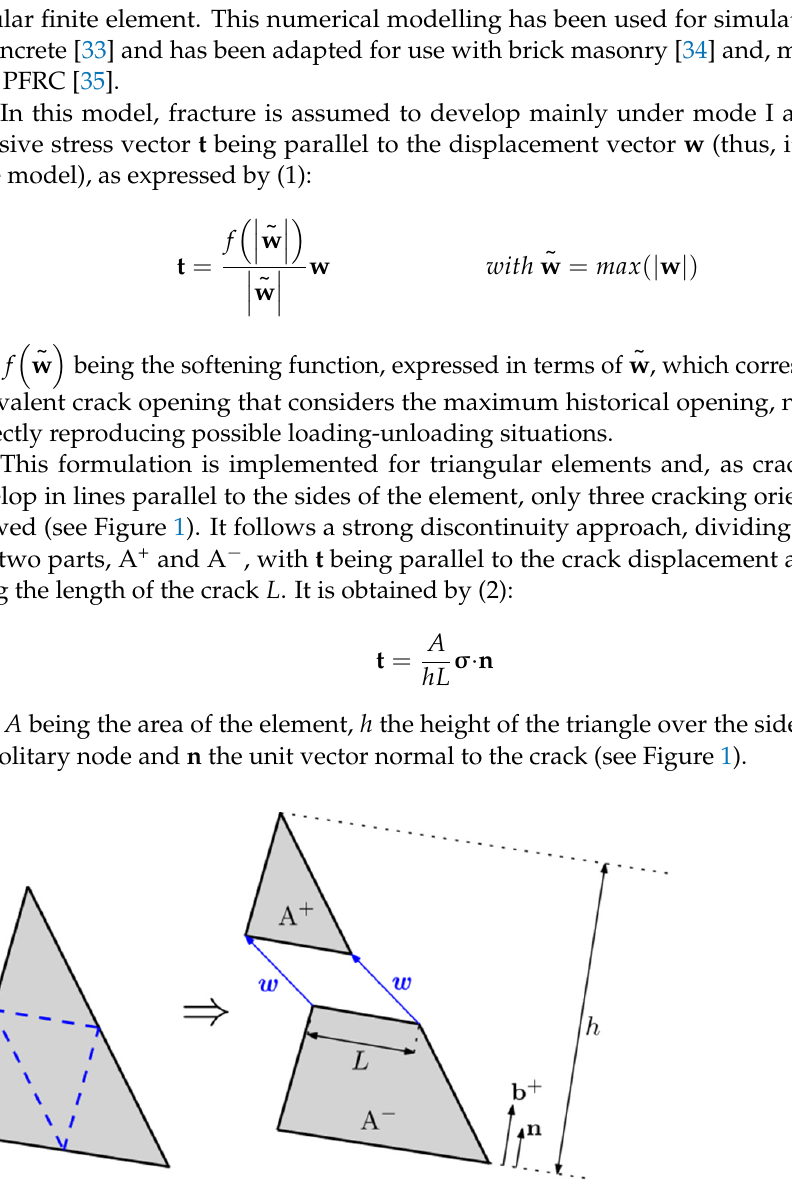
Figure 1. Possible crack paths ( left ) and geometrical definitions of 𝒘 , 𝐧 and 𝐛 (cid:2878) ( right